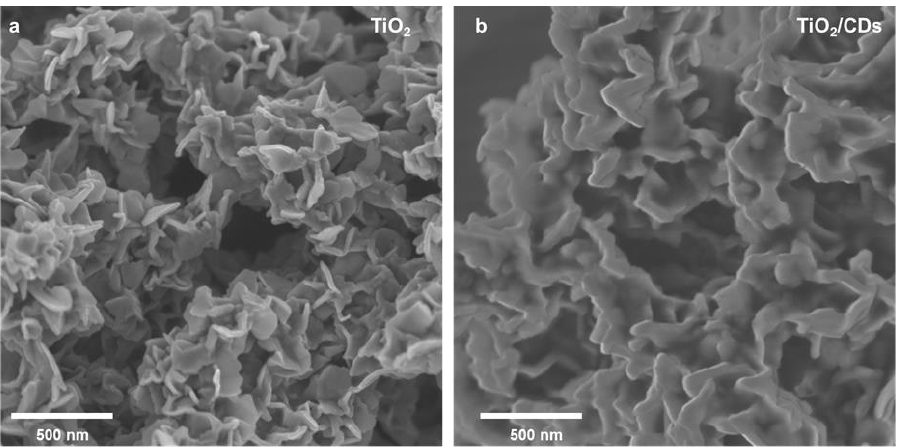
Figure 2. SEM image of ( a ) porous TiO 2 and ( b ) hybrid TiO 2 /CDs.